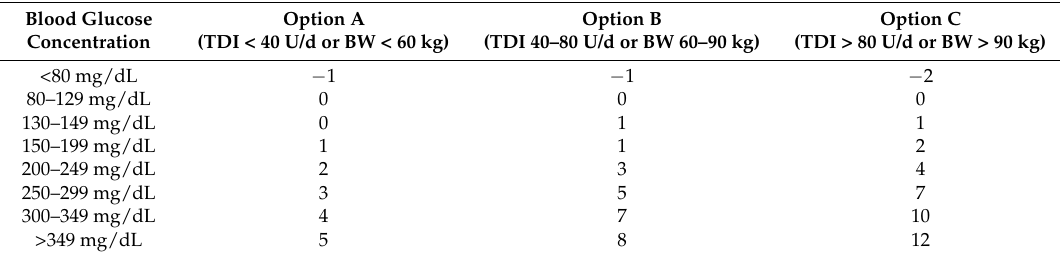
Table 1. Supplemental rapid-acting insulin